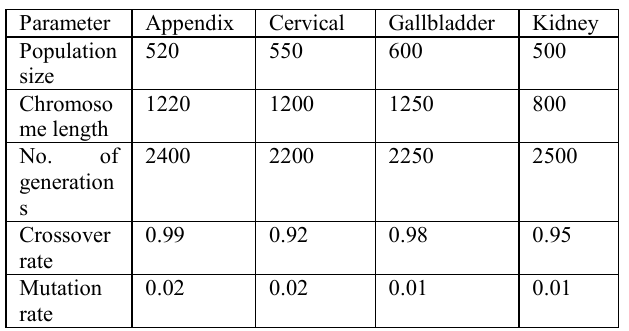
Table 2. Parameters for proposed technique for selection of genes data sets